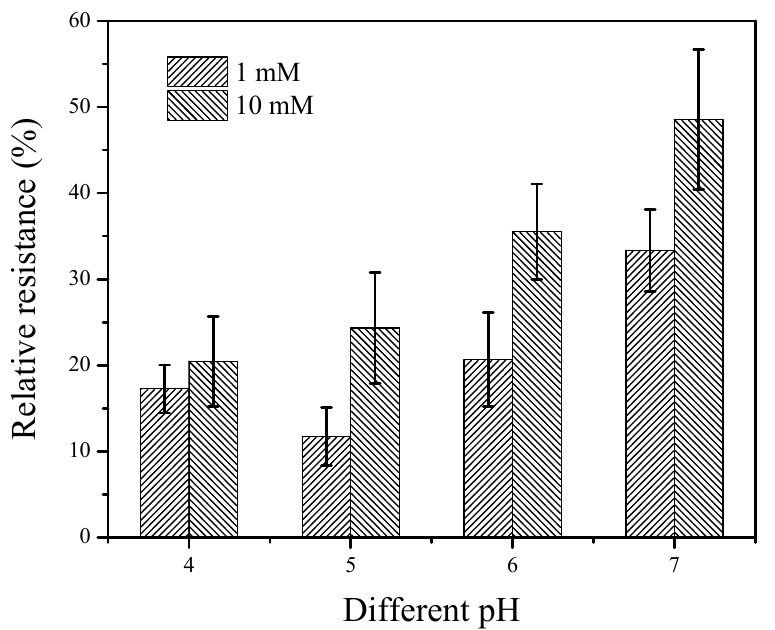
Figure 6. Relative resistance of the GCE/SWNT/DNAzyme after incubation in different Ca 2+ concentrations at various pH values.